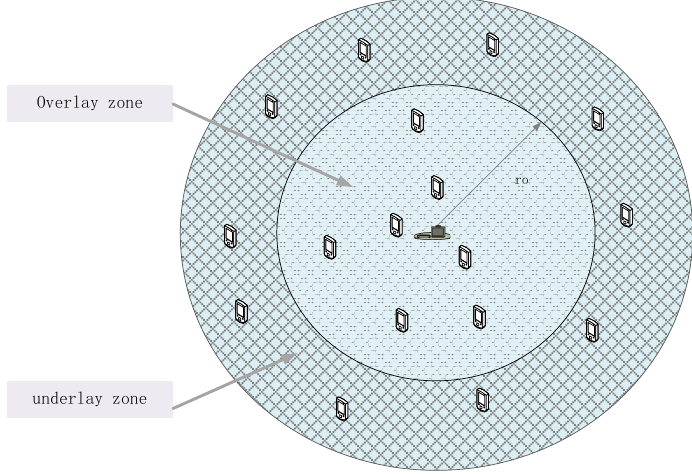
Figure 2. Area division map.